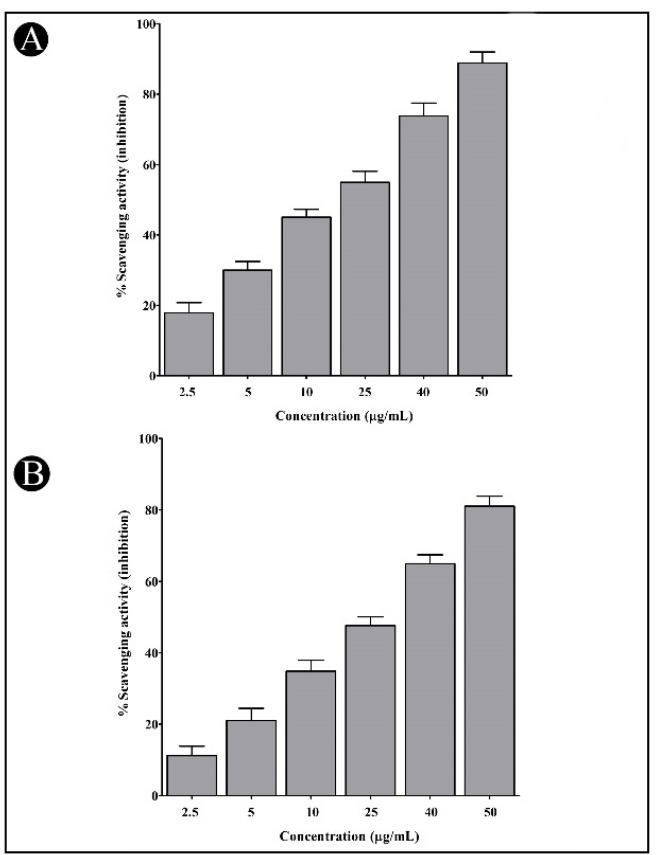
Figure 11. Antioxidant potential of synthesized AgNPs. ( A ) Antioxidant potential against DPPH free radical. ( B ) Antioxidant potential against H 2 O 2 molecules. Values are presented as mean ± SD of three independent tests.